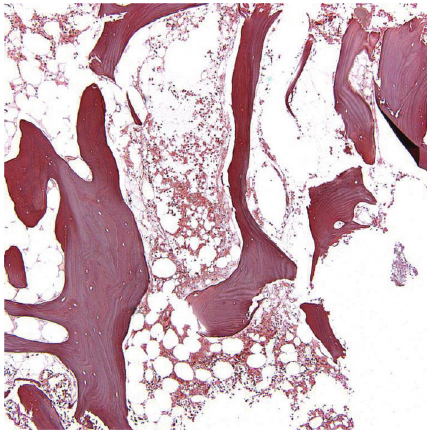
Figure 1: Bone marrow biopsy before treatment with romiplostim showing the absence of reticulin fibrosis (Silver stain, original mag- nification × 400).